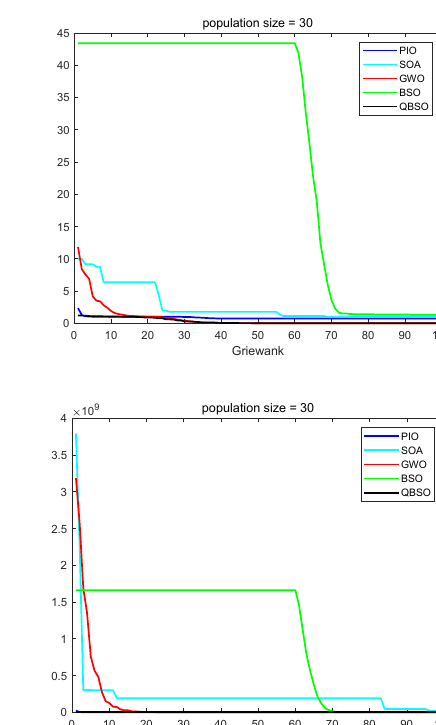
Figure 7. Population diversity at different iterations when optimizing the Griewank function with the population size = 30. 6. Conclusions In this paper, we propose the QBSO algorithm to address the inability of the BAS algorithm to handle high-dimensional optimization problems. Quantum representation was introduced into the algorithm, which can carry more population information with small-scale populations. To compare the performance with the PIO, SOA, GWO, and BSO algorithms, multiple comparison experiments with population sizes of 8 and 30 were con- ducted with unimodal benchmark functions and multimodal benchmark functions as the optimization objectives, respectively. The experimental results show that the QBSO algo- rithm still had satisfactory optimization capability at a population size of eight. The global